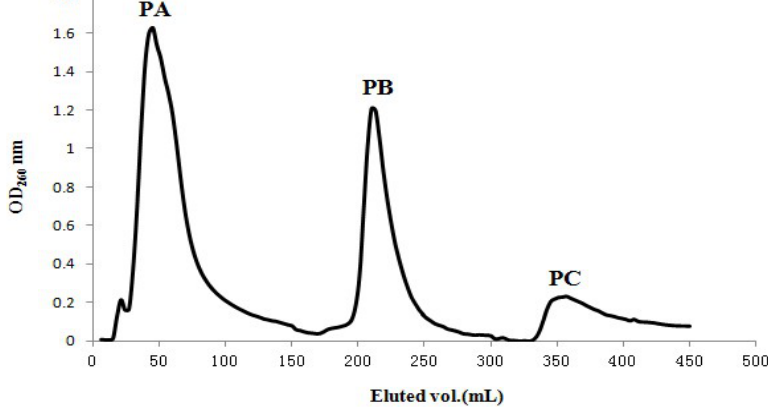
Figure 1. Elution profile of crude extract P from NKA macroporous resin column.